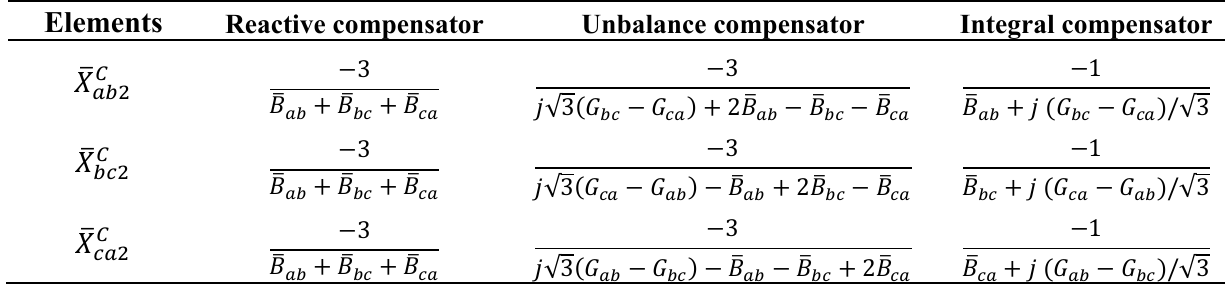
Table 2. Reactive, unbalance (negative-sequence) and integral (reactive + unbalance) compensators for the delta